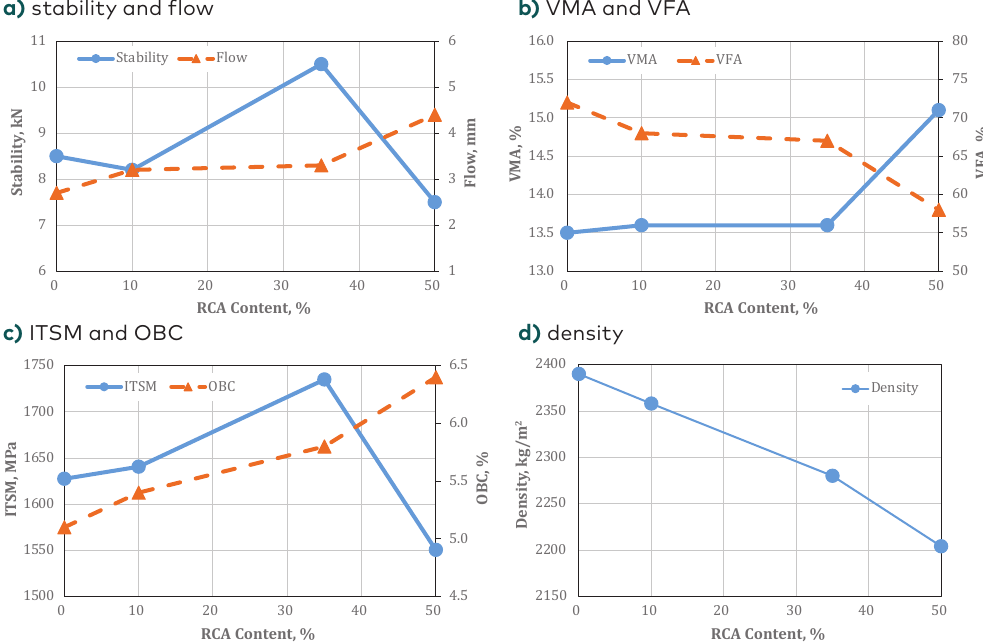
Figure 6. RCA-SMA properties (a) stability and flow; (b) VMA and VFA; (c) ITSM and OBC; (d)